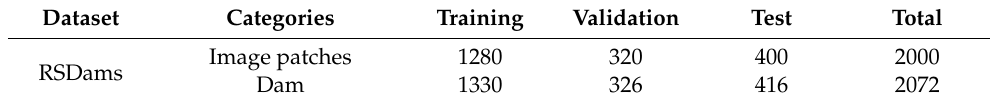
Figure 3. Examples of the visualization of bounding boxes for dams in the RSDams dataset. Table 1. The allocation of samples in RSDams for training, validation, and testing.